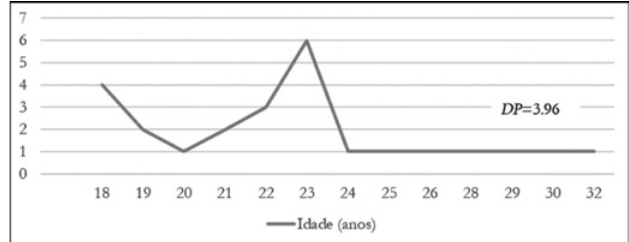
Figure 1: Variation of the age group of students with